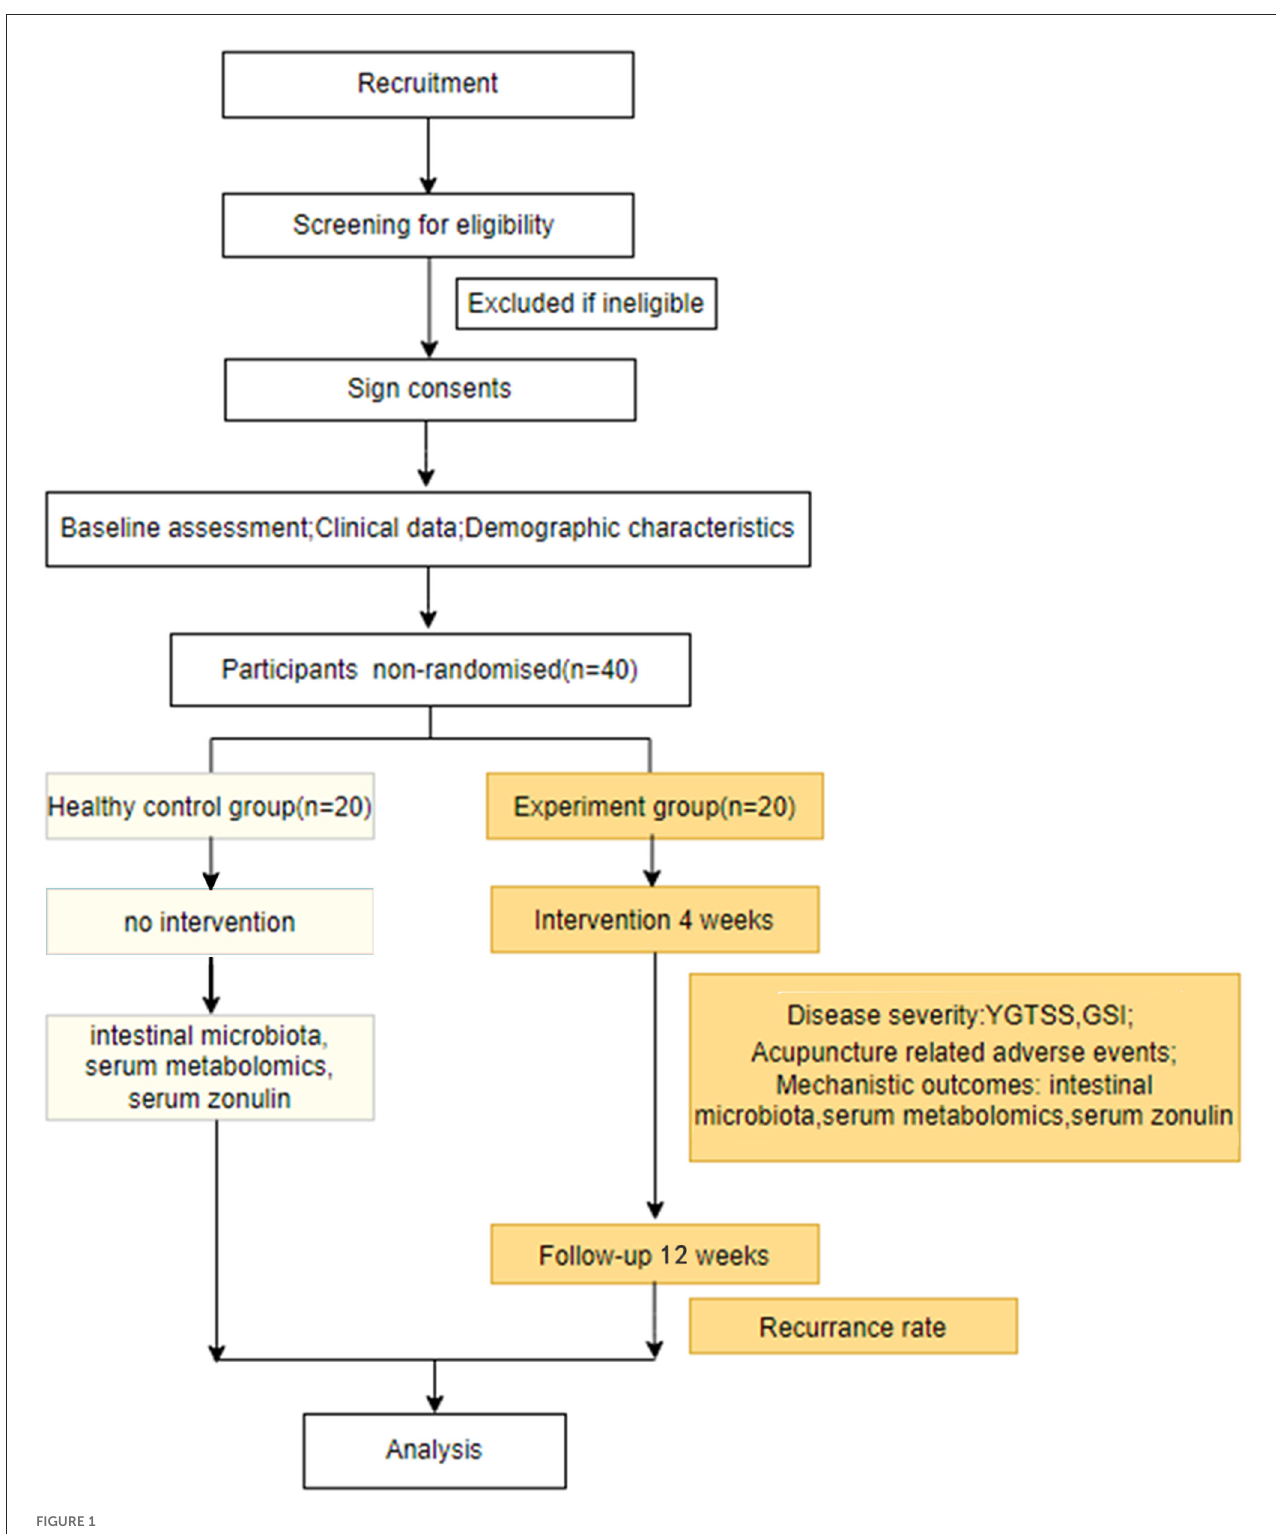
FIGURE1 Flow diagram.